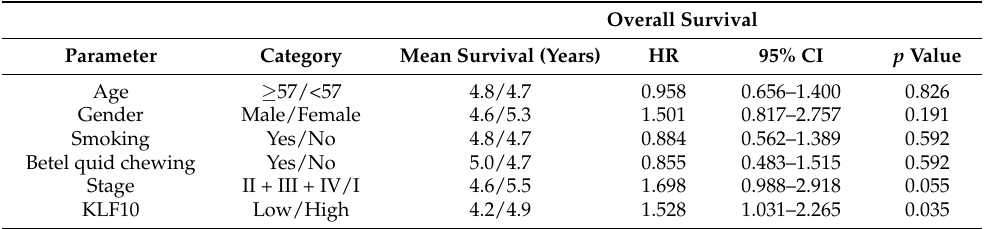
Table 3. Multivariate analysis of the influence of various parameters on the overall survival of oral cancer